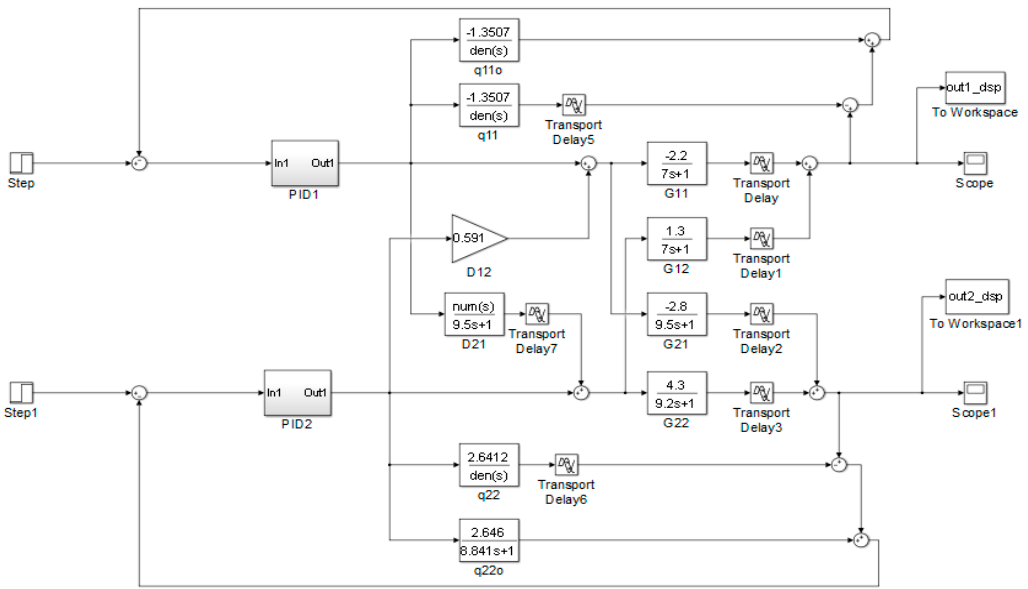
Figure 25. The implementing diagram of the DSP structure for VL column. The block diagram of Simulink program in Example 3, OR column.